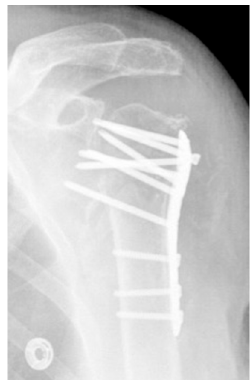
Figure 20. Complication Type 4b. a.p. radiograph of the left shoulder after angular stable plate osteosynthesis illustrates necrosis of the humeral head, implying cutout of multiple screws. This has resulted in arrosion of the glenoid articular surface.